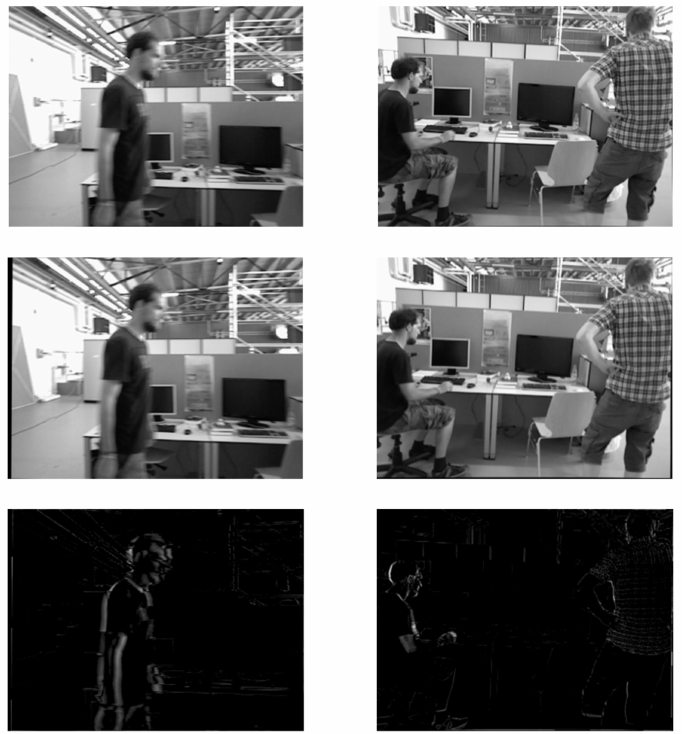
Figure 5. A set of sample raw images, mapping images with homography, transformation, and corresponding difference